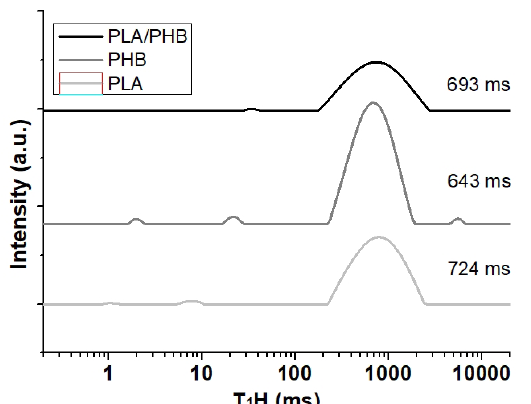
Figure 7. Distribution domain curves for the PLA, PHB and PLA/PHB